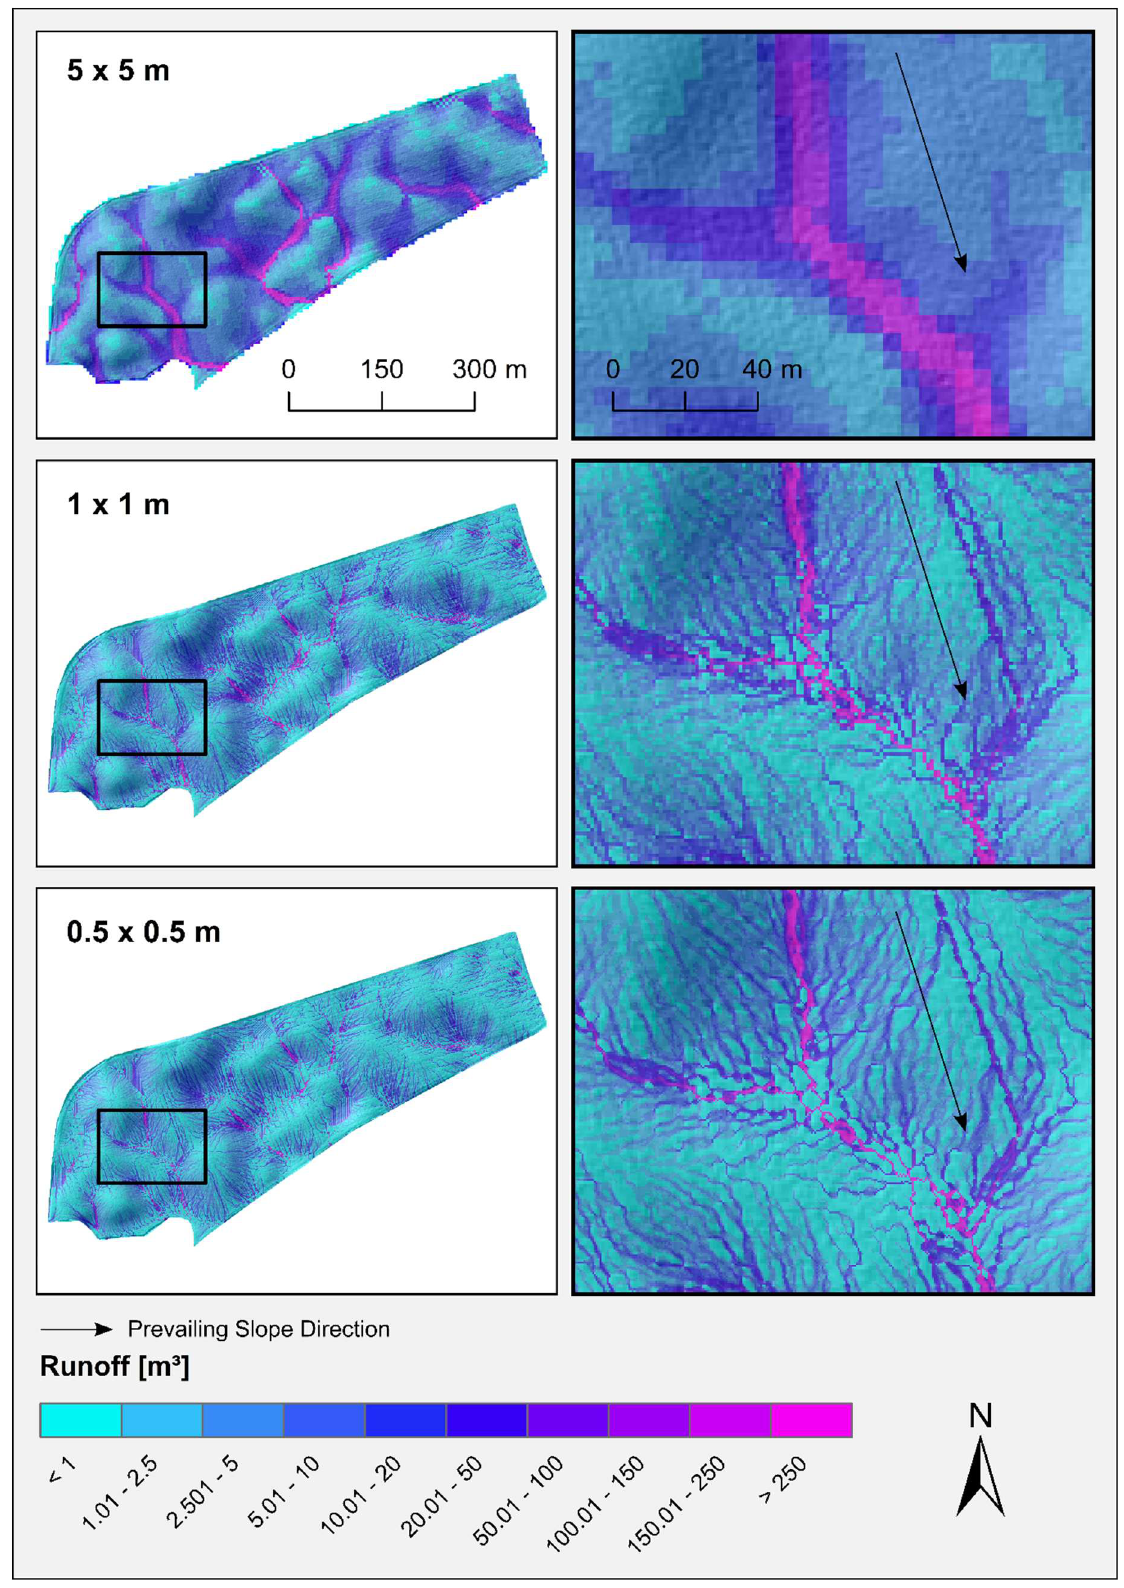
Figure A3. Visualization of simulated runoff from EROSION 3D for investigated resolutions on field B.